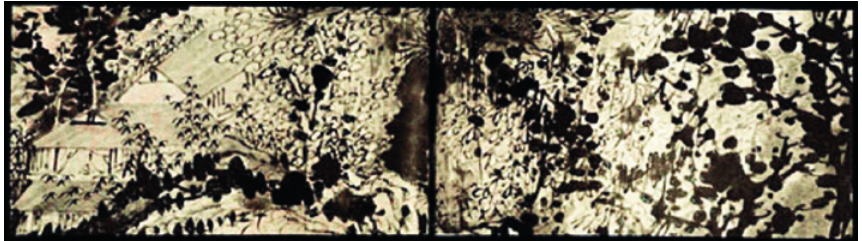
Fig. 6. Shi Tao. Ten Thousand Ugly Ink Blots